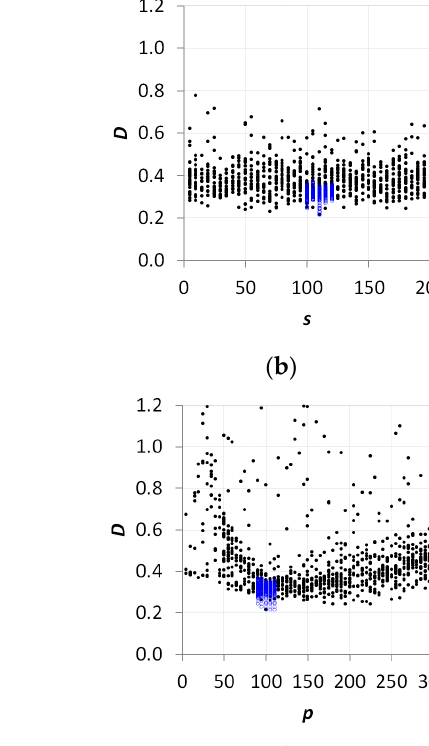
Remote Sens. 2023 , 15 , 262 11 of 23